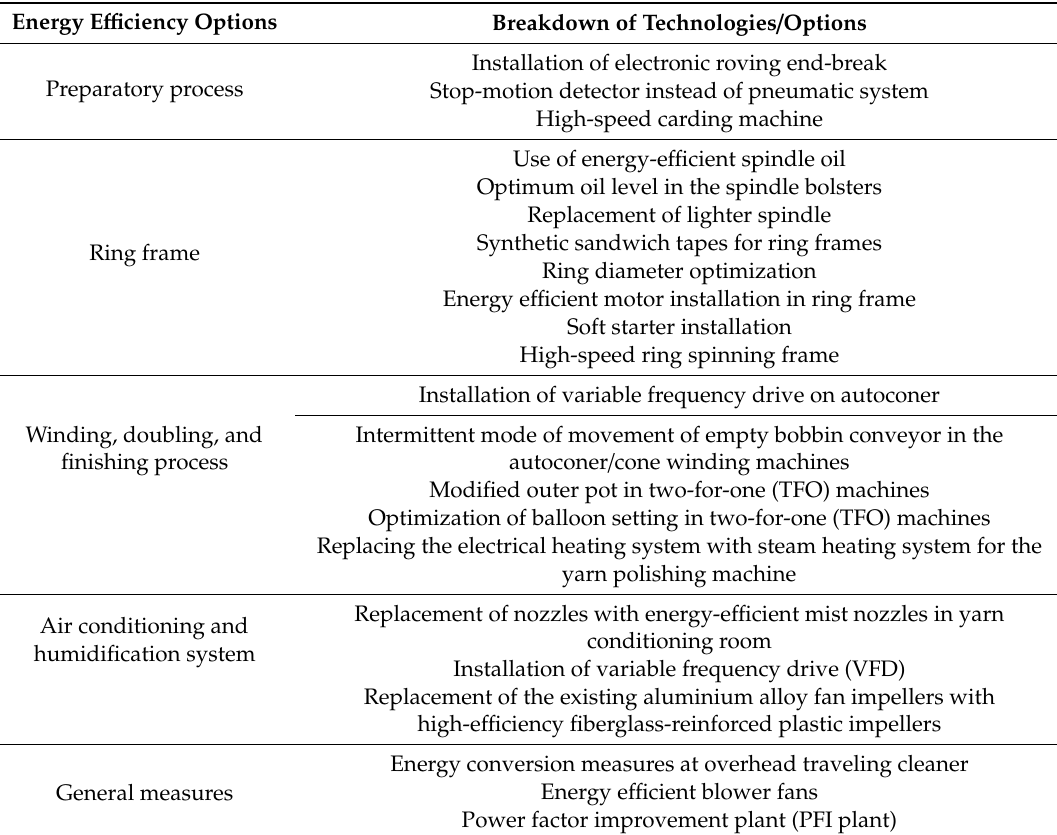
Table 4. Energy e ffi ciency options for the spinning process